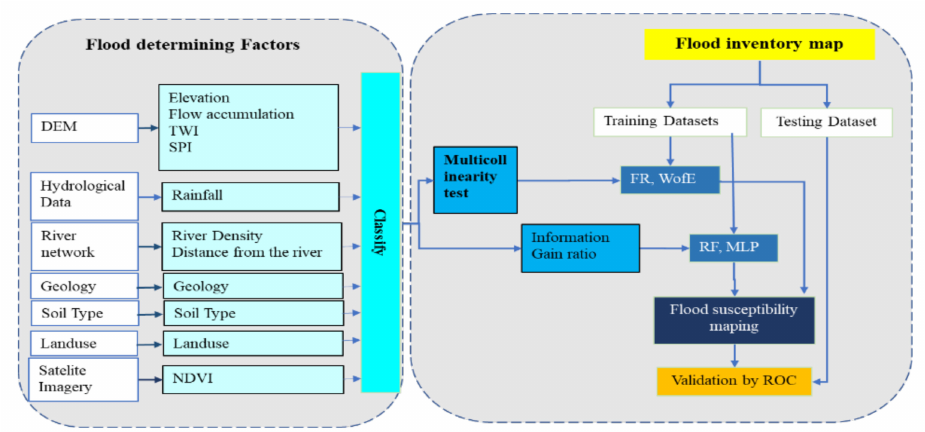
Figure 2. Flow chart of the research.